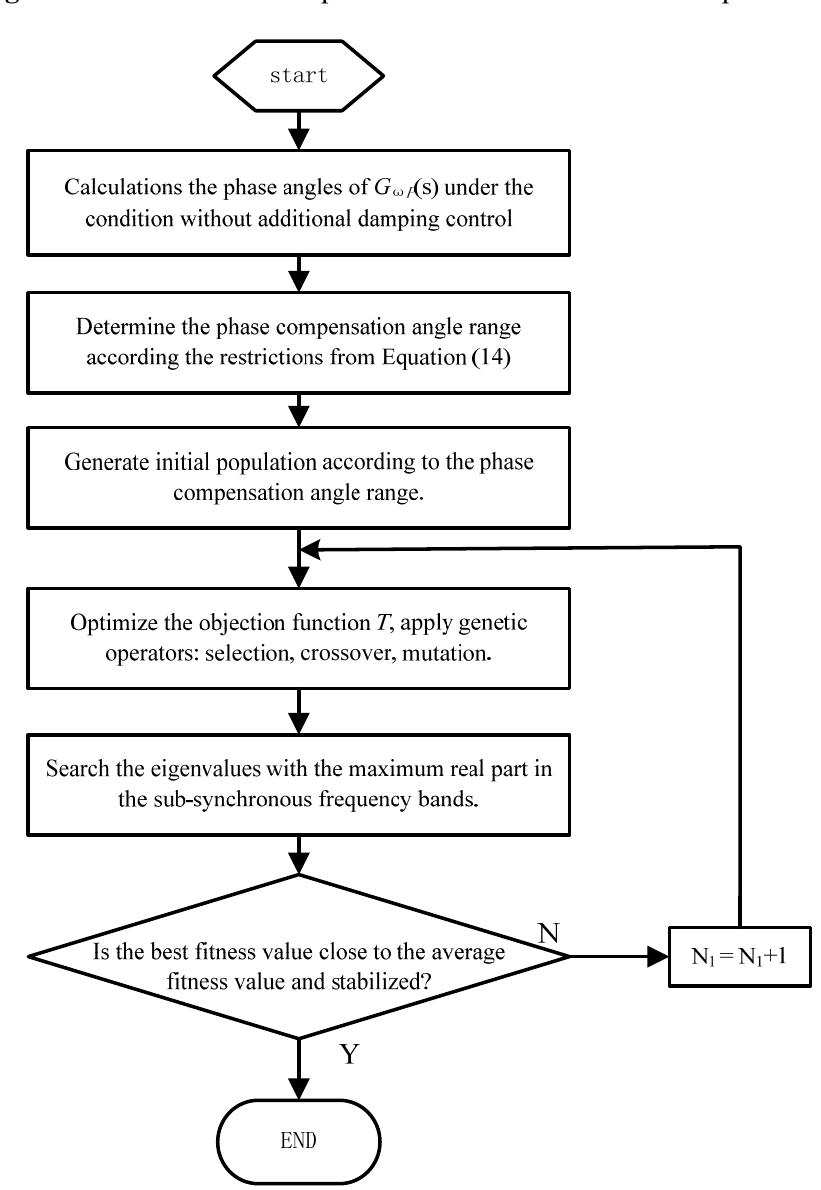
Figure 6. Flowchart of the optimization of the PID controller